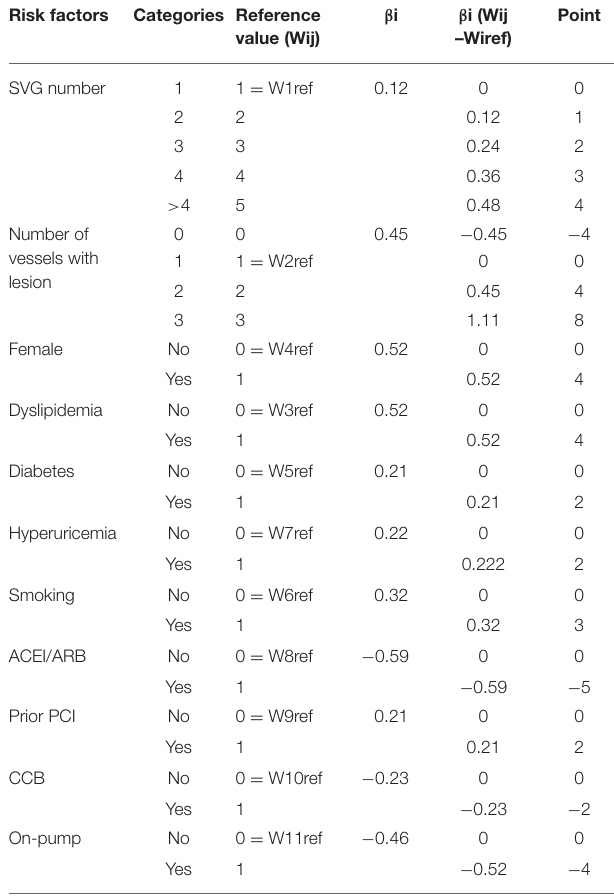
construction of the SVG occlusion score. Risk factors Categories Reference value